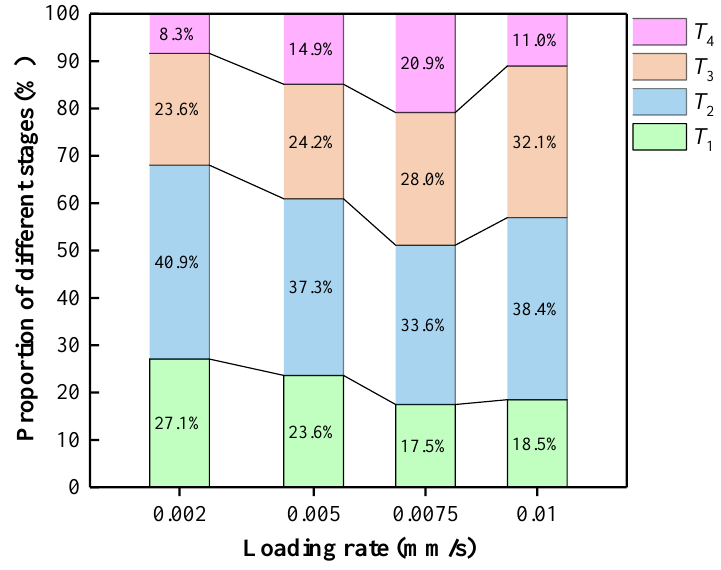
Figure 8. The proportion of each stage.